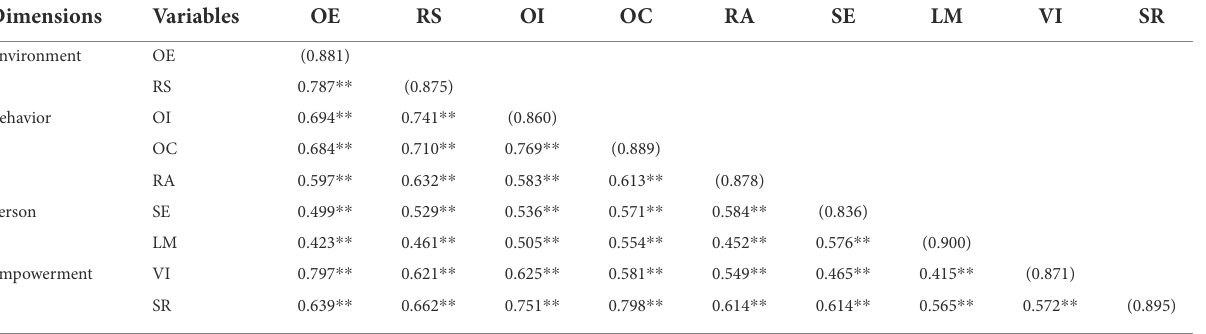
TABLE 2 Variable correlations and the discriminant validity for the measurement model.